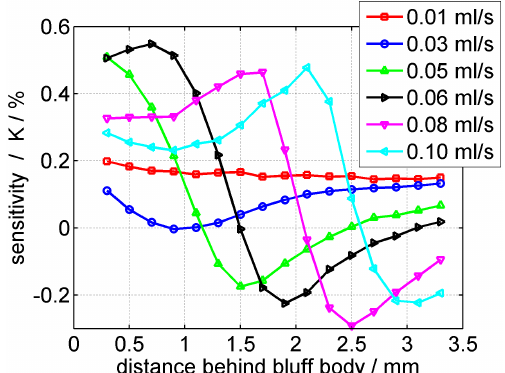
Figure 16. Measured sensitivity (defined as change in heater tem- perature divided by change in methanol fraction) of the individual heaters of the array for different flow rates.